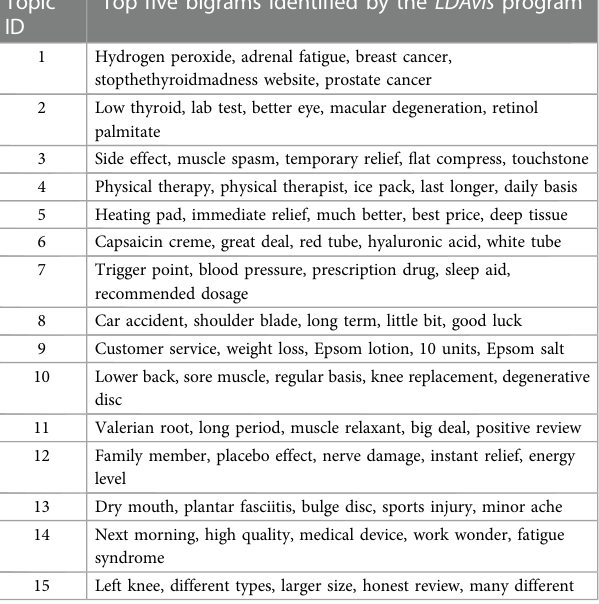
TABLE 3 Top fi ve salient terms of each LDA-discovered topic from the chronic pain-related product reviews. Topic Top fi ve bigrams identi fi ed by the LDAvis ID